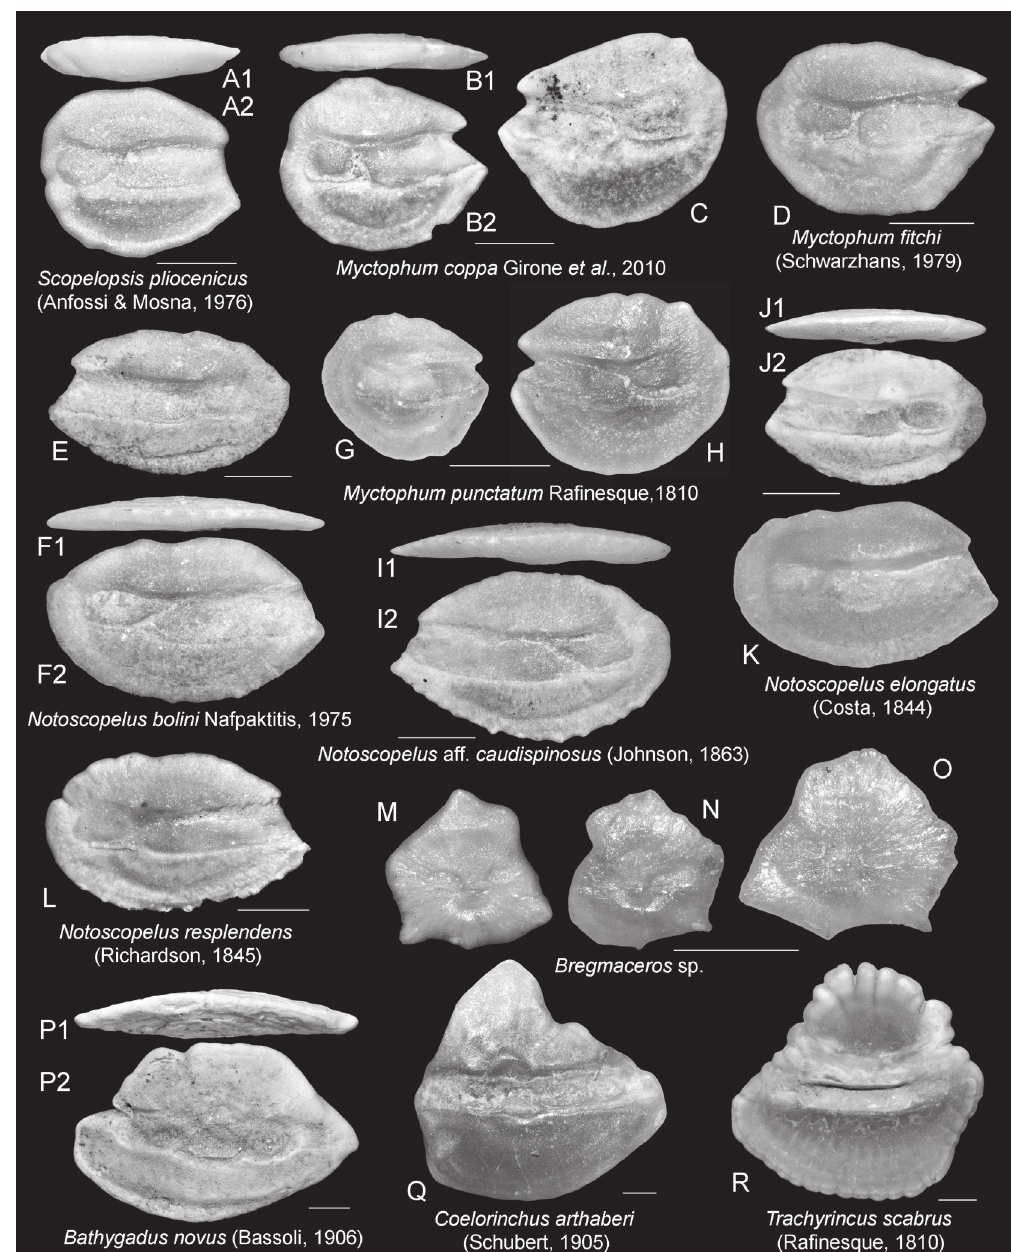
Fig. 7. Tortonian fish otoliths from northern Italy. A . Scopelopsis pliocenicus (Anfossi &